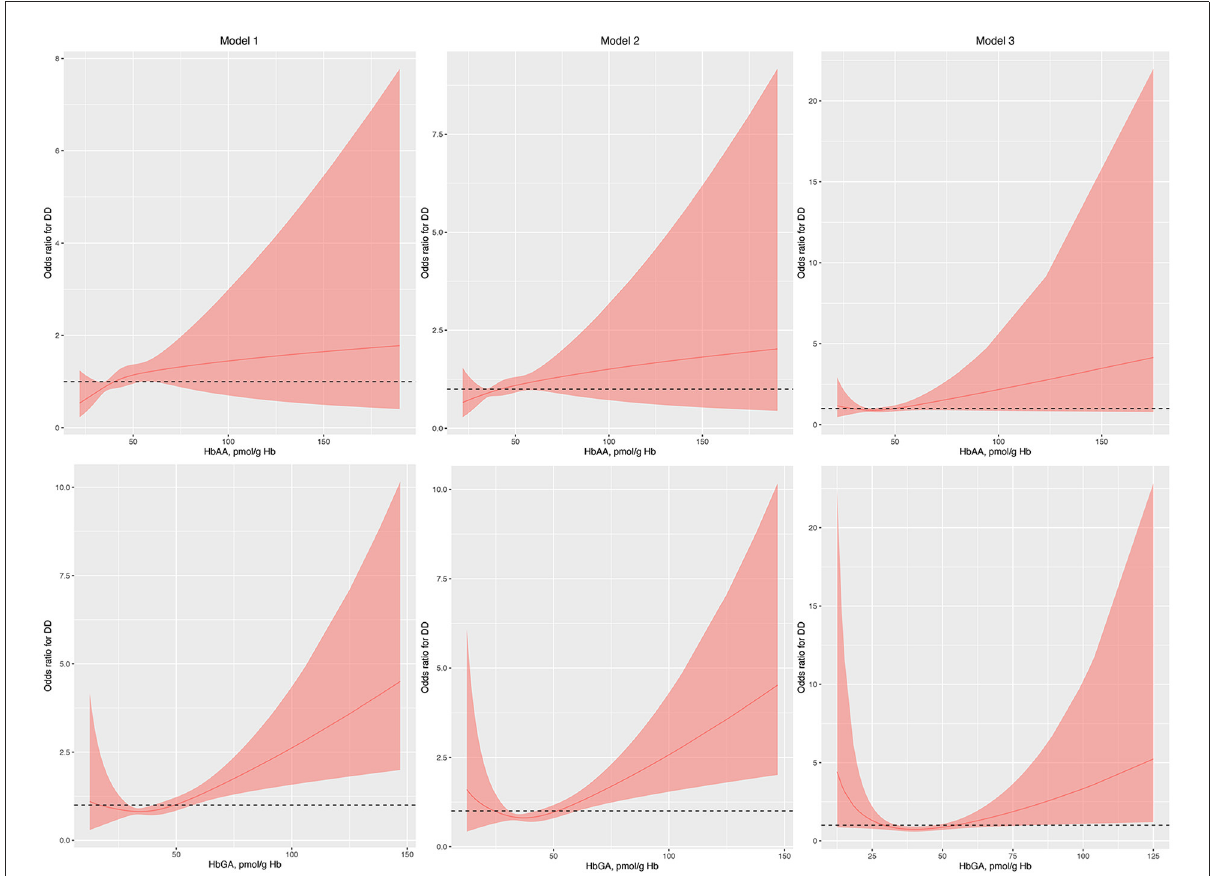
FIGURE2 Odds ratio (95% confidence interval) of developmental disabilities by blood HbAA and HbGA levels after propensity score matching. Odds ratio (solid lines) and 95% confidence interval (curved lines) were based on binomial regression analysis with restricted cubic splines for log-transformed HbAA and HbGA levels. No covariables were adjusted for in model 1. Age, gender, race, and income were adjusted in model 2. Age, gender, race, income, BMI, normal birth weight, maternal smoking during pregnancy, health insurance coverage, and the number of annual health care visits were adjusted in model 3. BMI, body mass index; DDs, developmental disabilities; Hb, hemoglobin; HbAA, hemoglobin adducts of acrylamide; HbGA, hemoglobin adducts of